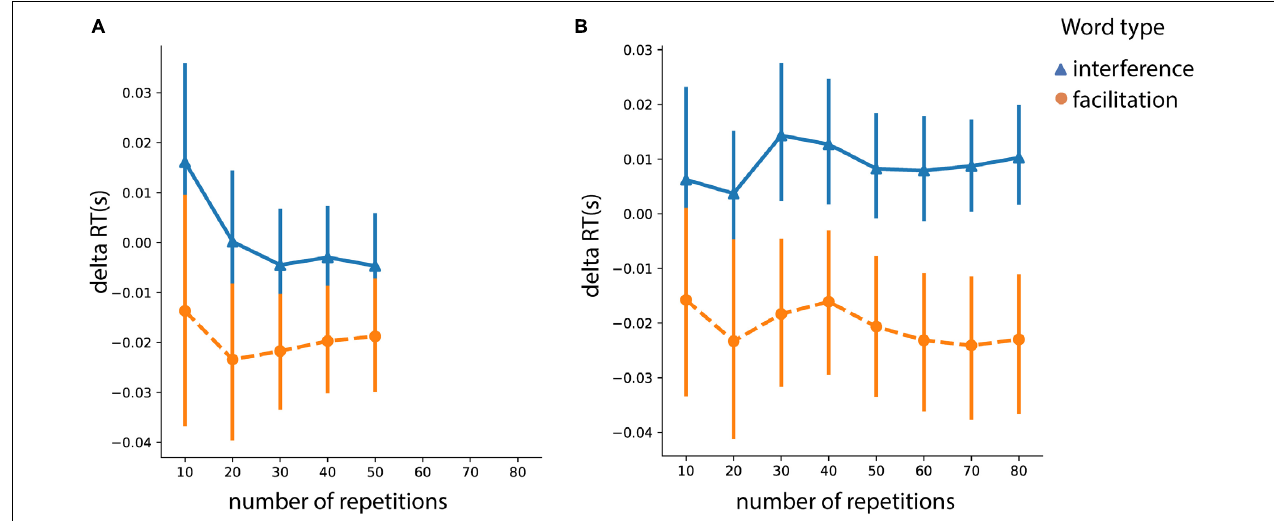
FIGURE 6 | Interference and facilitation effects across trials for (A) associative words (“beard”/“skirt”) and (B) identity (“man”/“woman”) words. Error bars represent 95% confidence interval (CI); RT, response time.